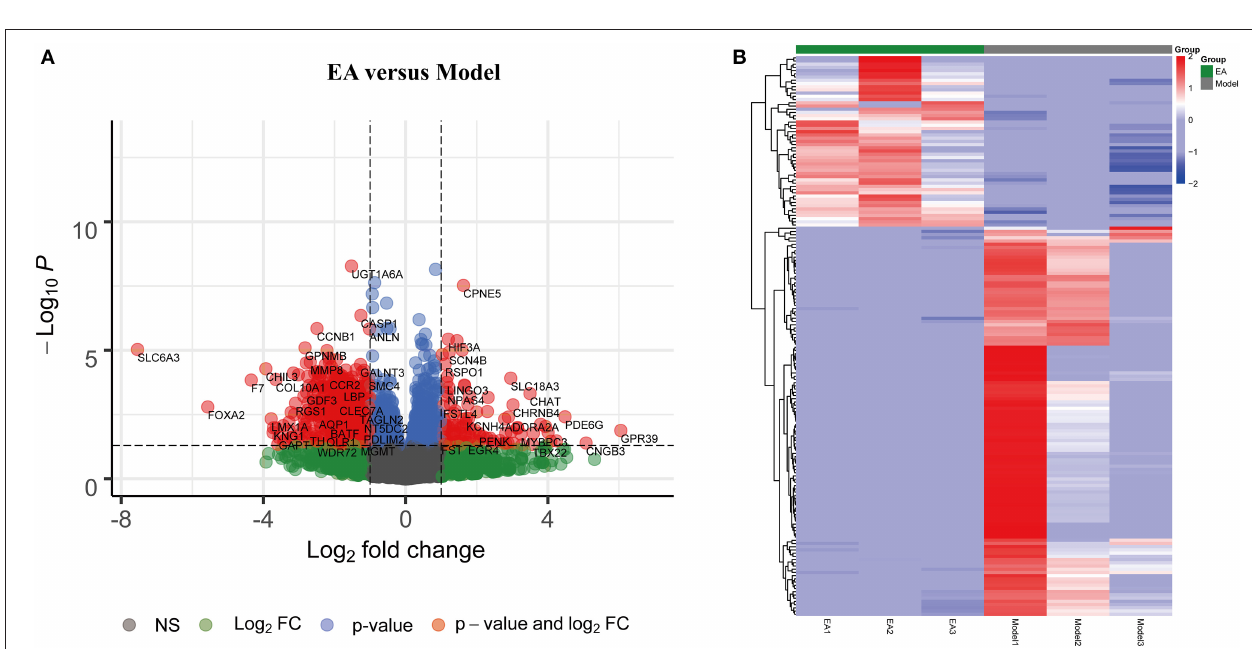
FIGURE 2 | Significant differentially expressed genes (DEGs) between the EA and MCAO control groups. (A) Volcano plot showing significant gene expression profiles in the MCAO + EA group compared with the MCAO control group. Red points and blue points represent downregulated and upregulated DEGs, respectively. (B) Heat map and hierarchical clustering of DEGs between the MCAO and MCAO + EA groups. The deeper red color shows the higher gene expression, while the deeper blue color indicates the lower expression. n = 3